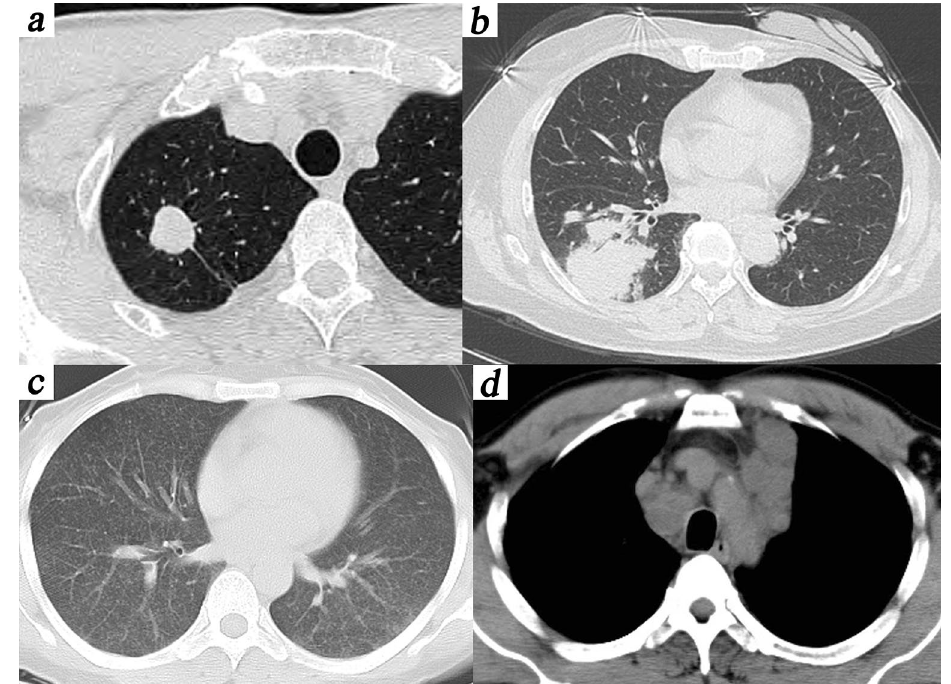
Figure 1. The CT manifestations of PC patients: ( a ) A 41-year-old male with normal immune function indexes was asymptomatic. Nodular type: A single nodule with smooth margins and uniform density was seen in the upper lobe of the right lung. ( b ) A 58-year-old female, after breast cancer surgery, was infected with Cryptococcus in the lungs during chemotherapy, with symptoms of fever and cough. Consolidation and air bronchial signs were seen in the right lower lobe. ( c ) A 38-year-old female presented with a pulmonary infection of Cryptococcus during corticosteroid therapy, with fever and cough. Miliary pattern: Multiple miliary nodules were seen in both lungs. ( d ) A 50-year-old male was immunocompromised and had cough. Mediastinal lymphadenopathy was seen in her lung CT.